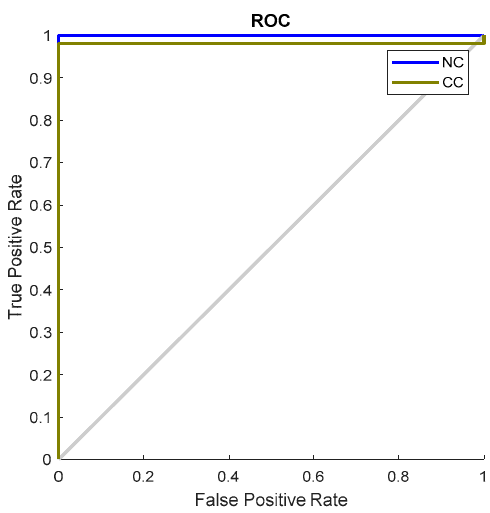
Figure 13. AUC-ROC of the proposed DNN classifier.